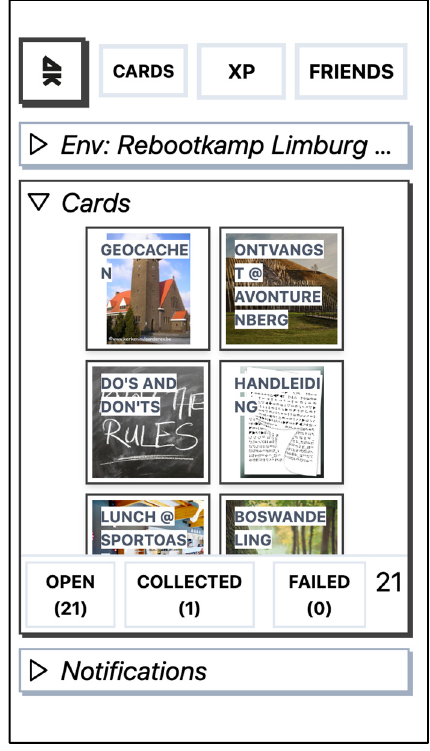
Figure 4. Overview of the cards of a youngster for a card environment.